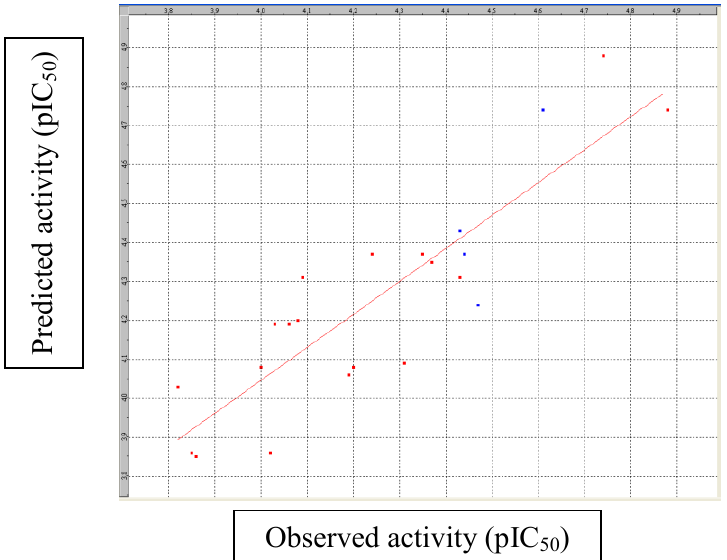
Figure 2 Comparison of observed activity versus predicted activity for training set & test set compounds according to 3D-QSAR model by k NN